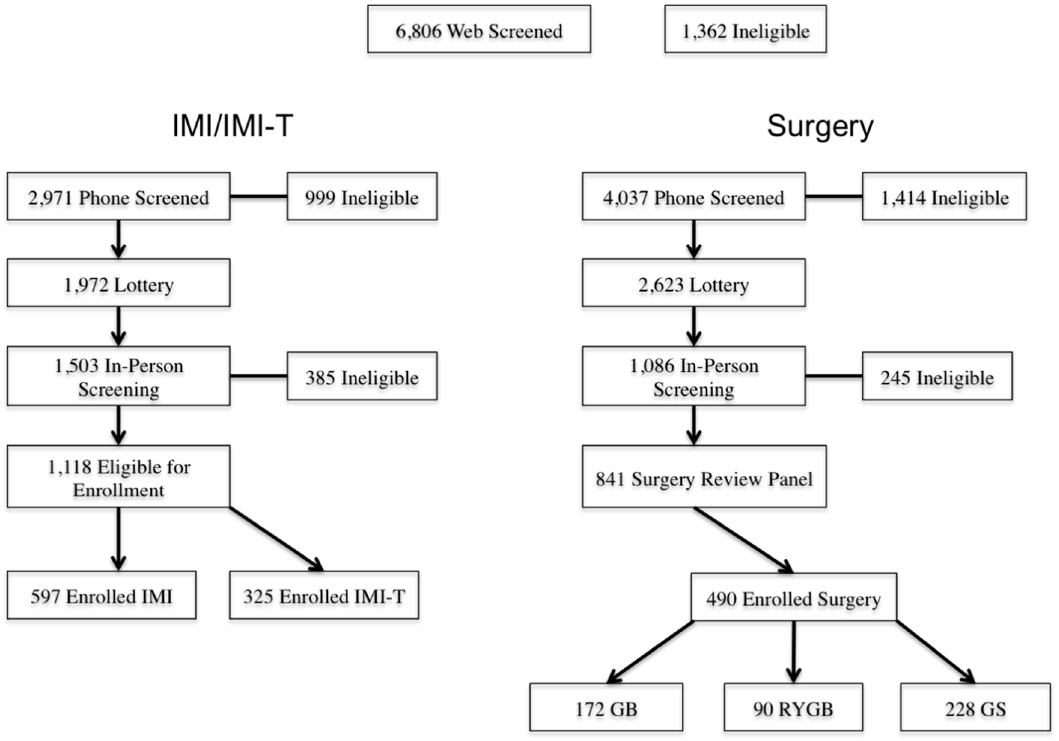
Figure 1. Screening Process.